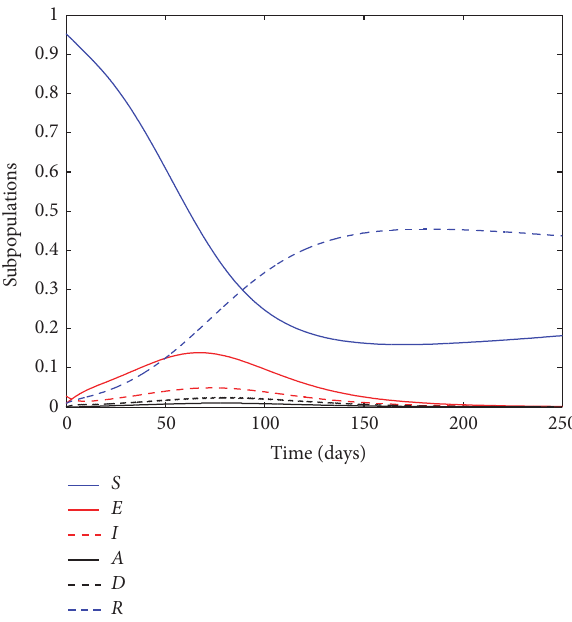
Figure 12: Evolution of the subpopulations with daily culling rate of = 0.1 and constant vaccination of 𝑉 = 𝑉 𝜌 𝐷